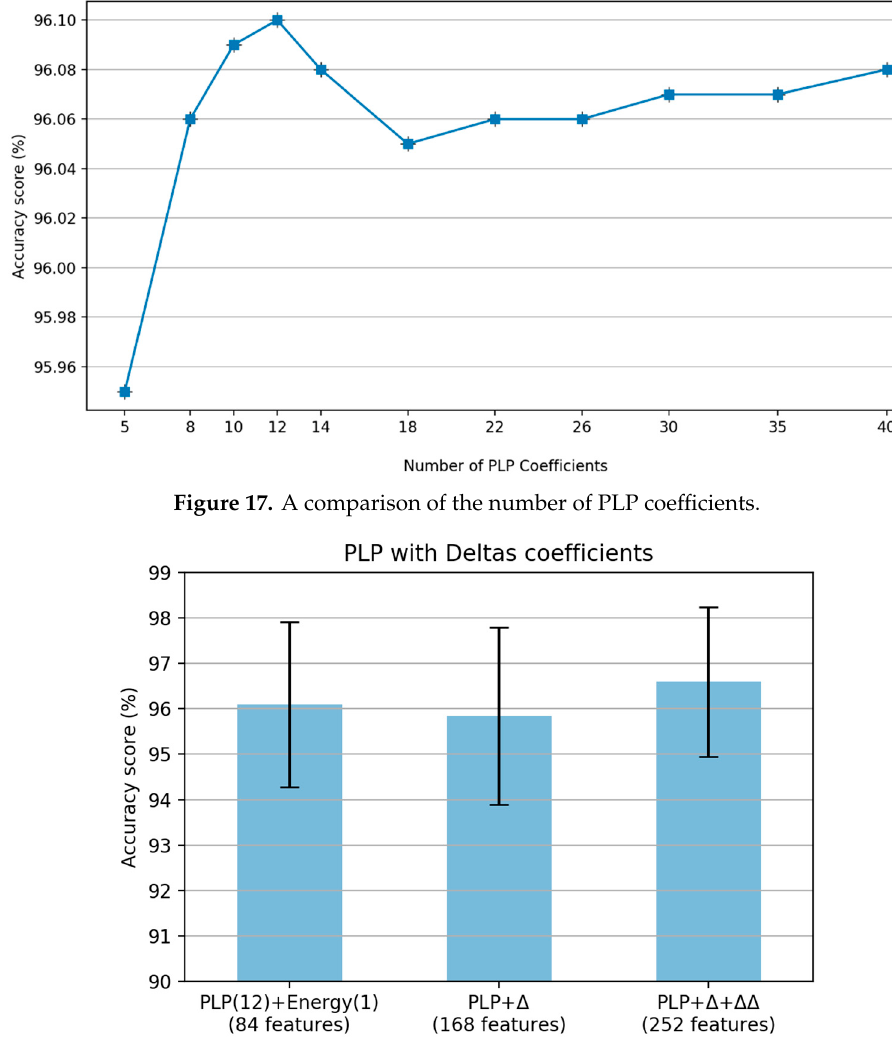
Figure 18. Accuracy score based on PLP with deltas coefficient.